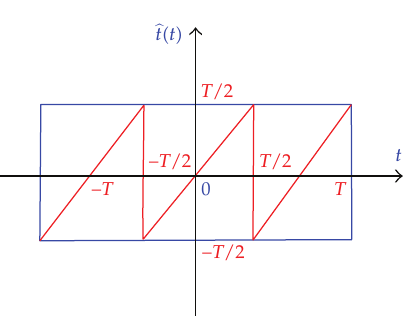
Figure 1: The periodical saw-tooth function for time operator for the case of (cid:2) 2.42 (cid:3)